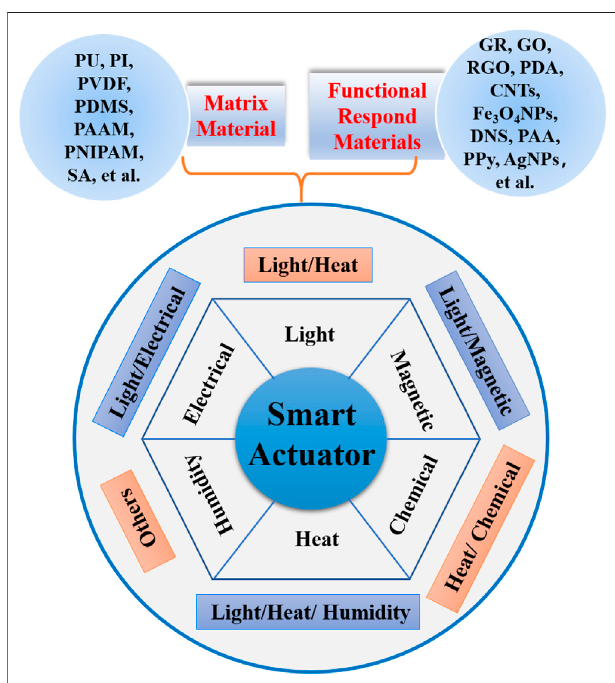
FIGURE 1 | Classi fi cation and composition of smart actuators based on single/multiple responses to different stimuli.